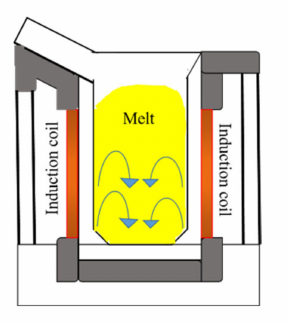
Figure 5. Induction melting